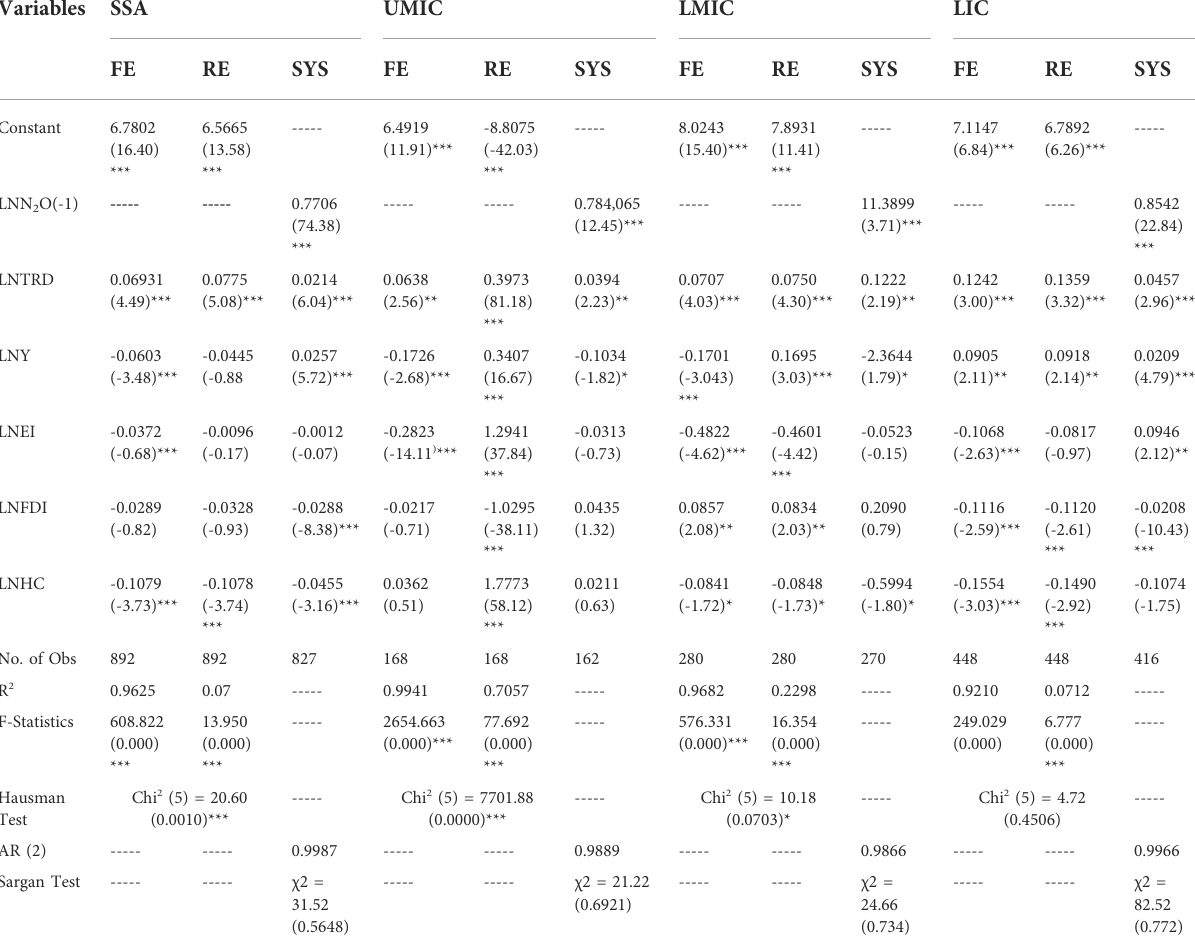
TABLE 1 Panel estimation results: LNN 2 O as the dependent variable. Variables